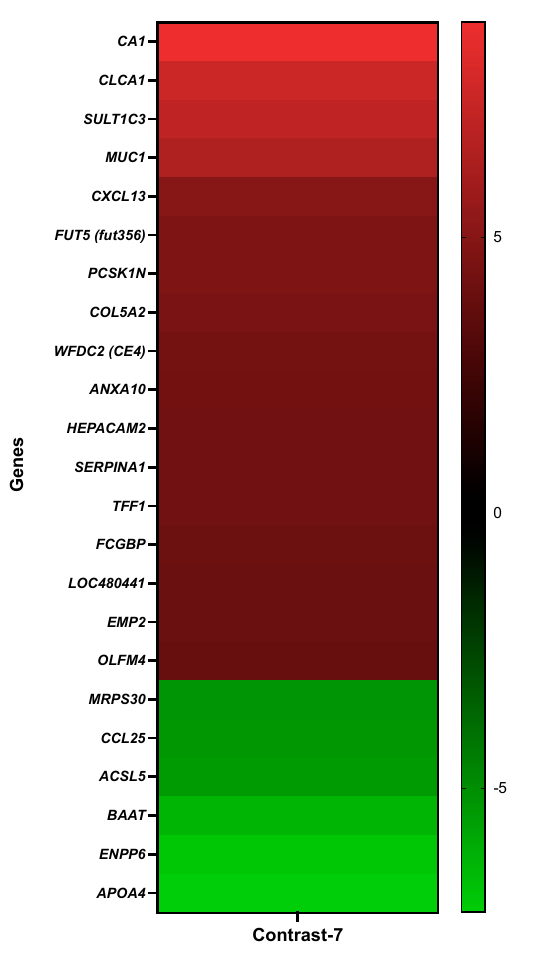
Figure 8. A heat map depicting the color-coded expression levels (log-ratio M values) of the top 17 upregulated and six downregulated DEGs in the LPS treated IBD enteroids vs. the LPS treated tumor enteroids (Contrast-7). The log-ratio M values represent the log(R/G) (log fold change) [44]. The detailed information on genes is presented in Table 10.